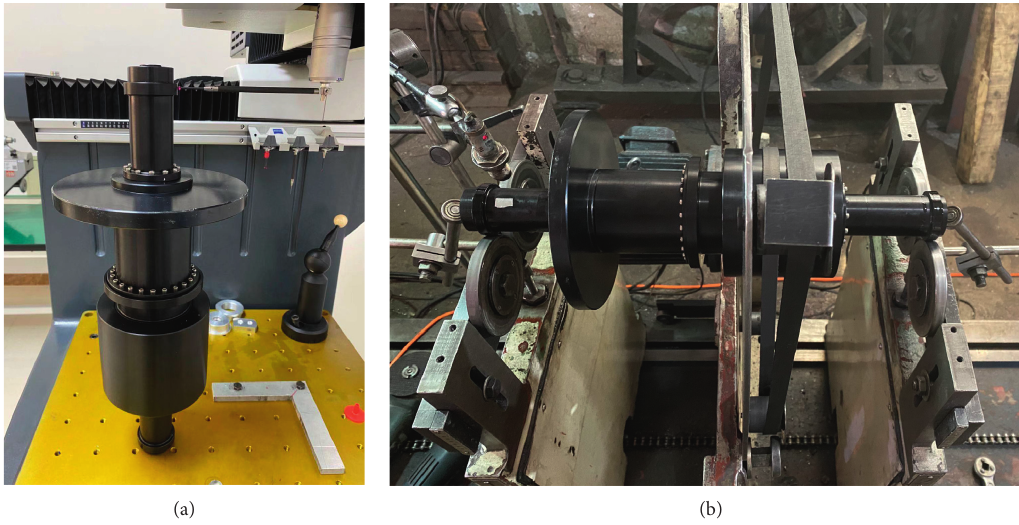
Figure 12: The setup picture for measuring the geometric and mass parameters of the four-stage rotor. (a) The geometric parameters are measured by CMM. (b) The mass parameters are measured by dynamic balancing